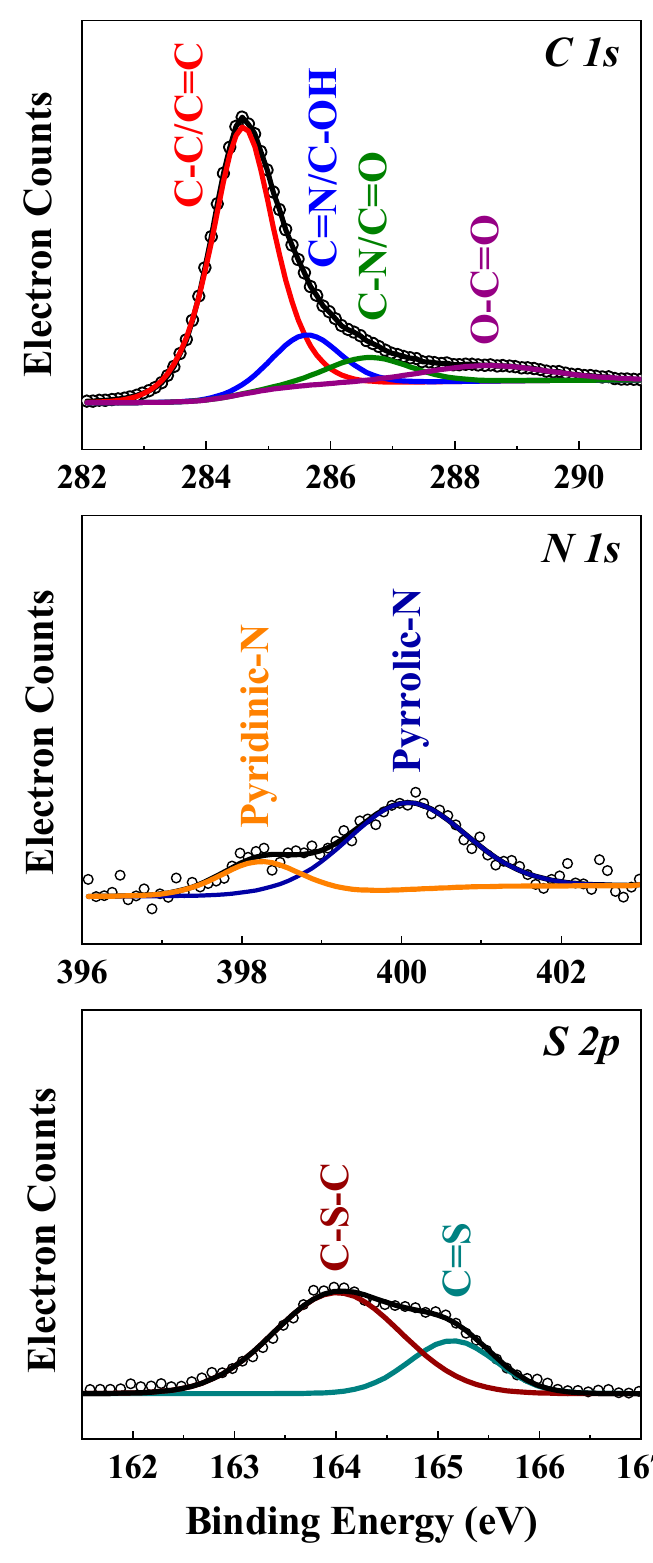
Figure 2. XPS spectra of the MPC sample for C 1s, N 1s, and S 2p.